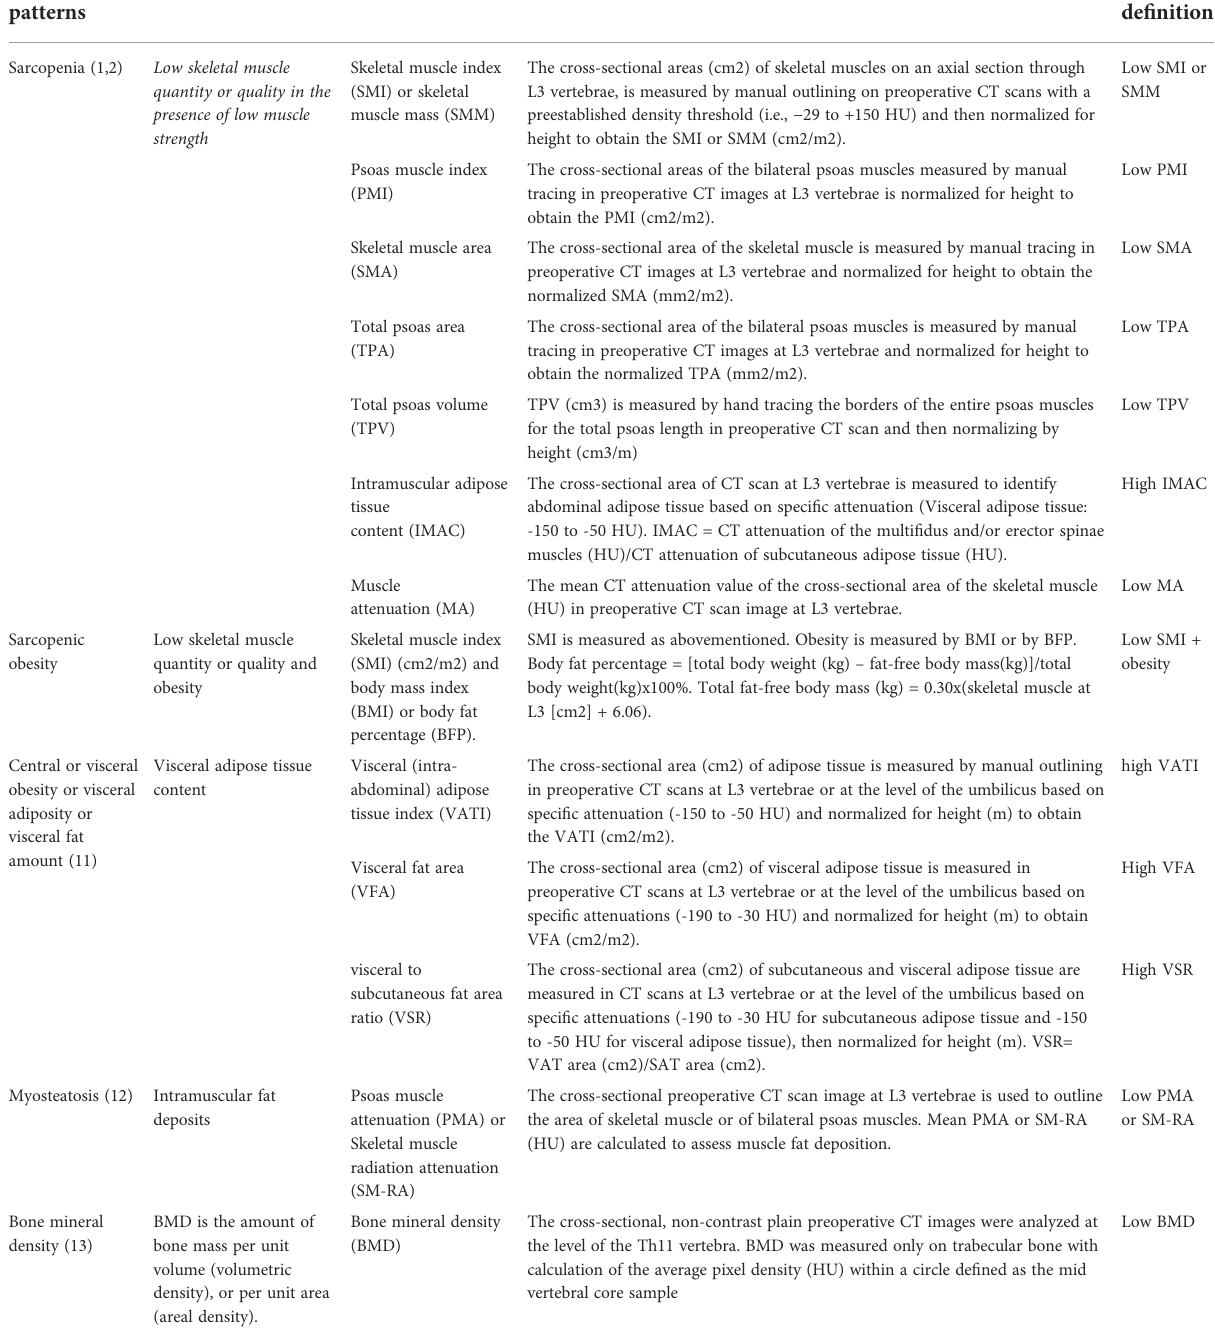
TABLE 1 Synopsis of body composition patterns, de fi nitions and measures used in the